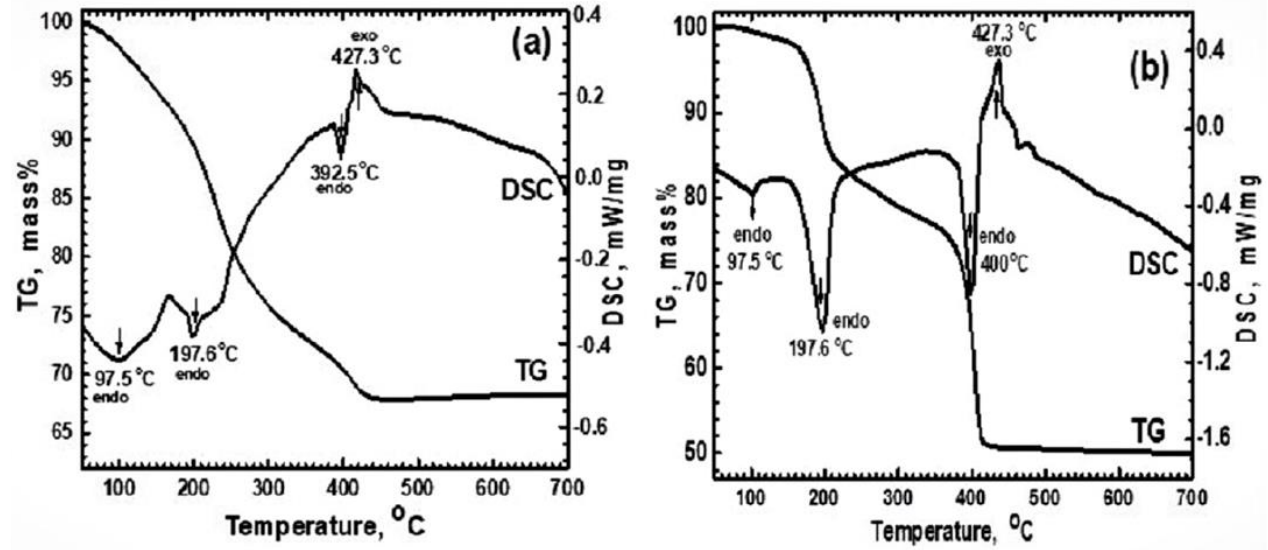
Figure 1. TG-DSC analysis of precursors thermally heated up to 700 °C in Ar gas atmosphere; ( a ) precursor A; and ( b ) precursor B.